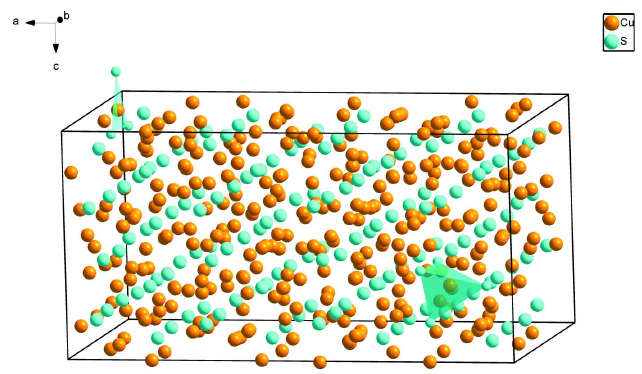
Figure 1 The unit cell of Cu 61.39 S 32 , with sites Cu1 and Cu48 displayed with their different coordination environments as